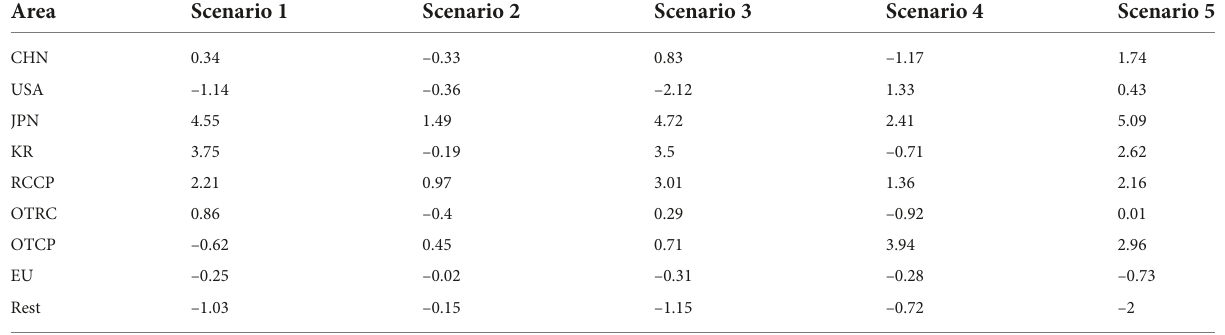
TABLE 6 Impact on trade terms (%).